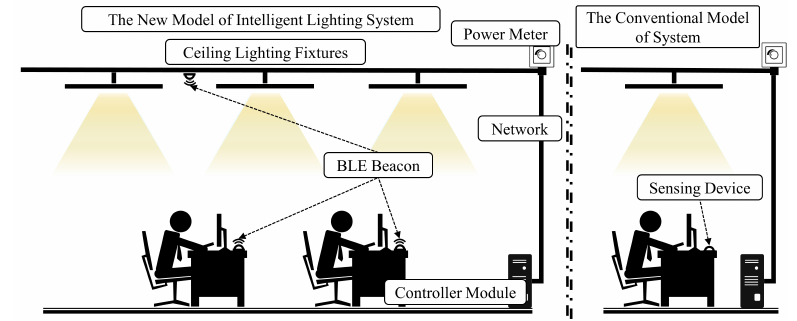
Figure 1. The intelligent lighting system in two designs. The traditional system on the right side, and on the left side, the new design of the